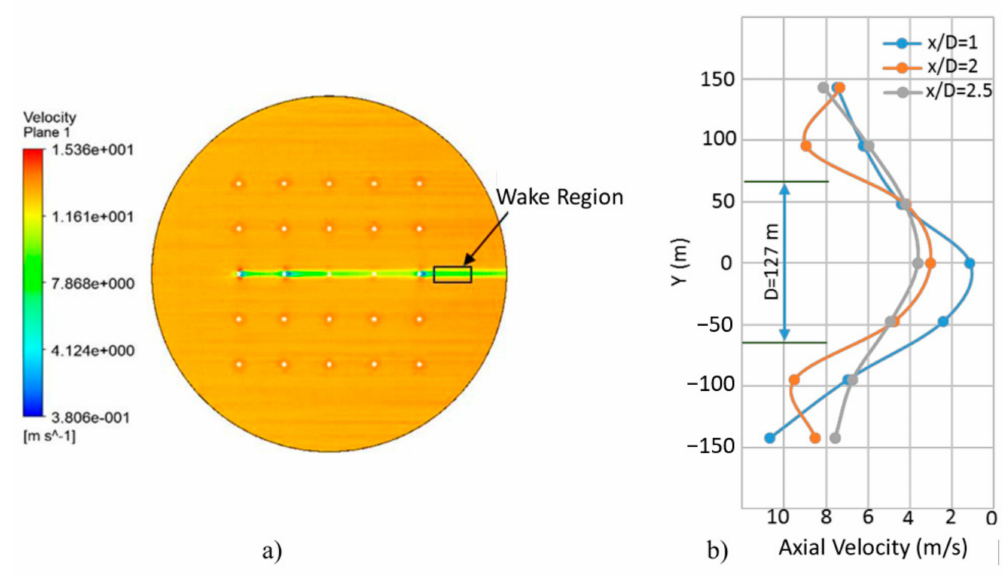
Figure 6. The wind speed in the wake region: ( a ) top view of wind farm and ( b ) wind turbine wake